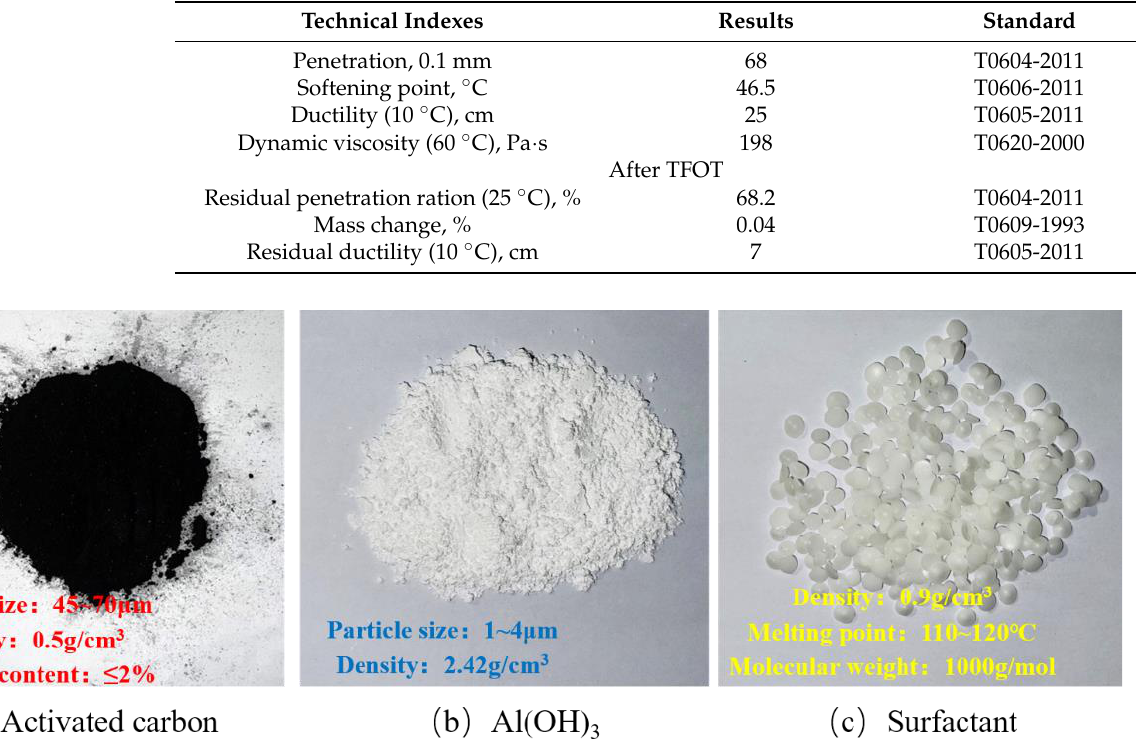
Figure 1. The schematics and properties of additives added for emission reduction; ( a ) Activated carbon, ( b ) Al(OH) 3 , ( c )